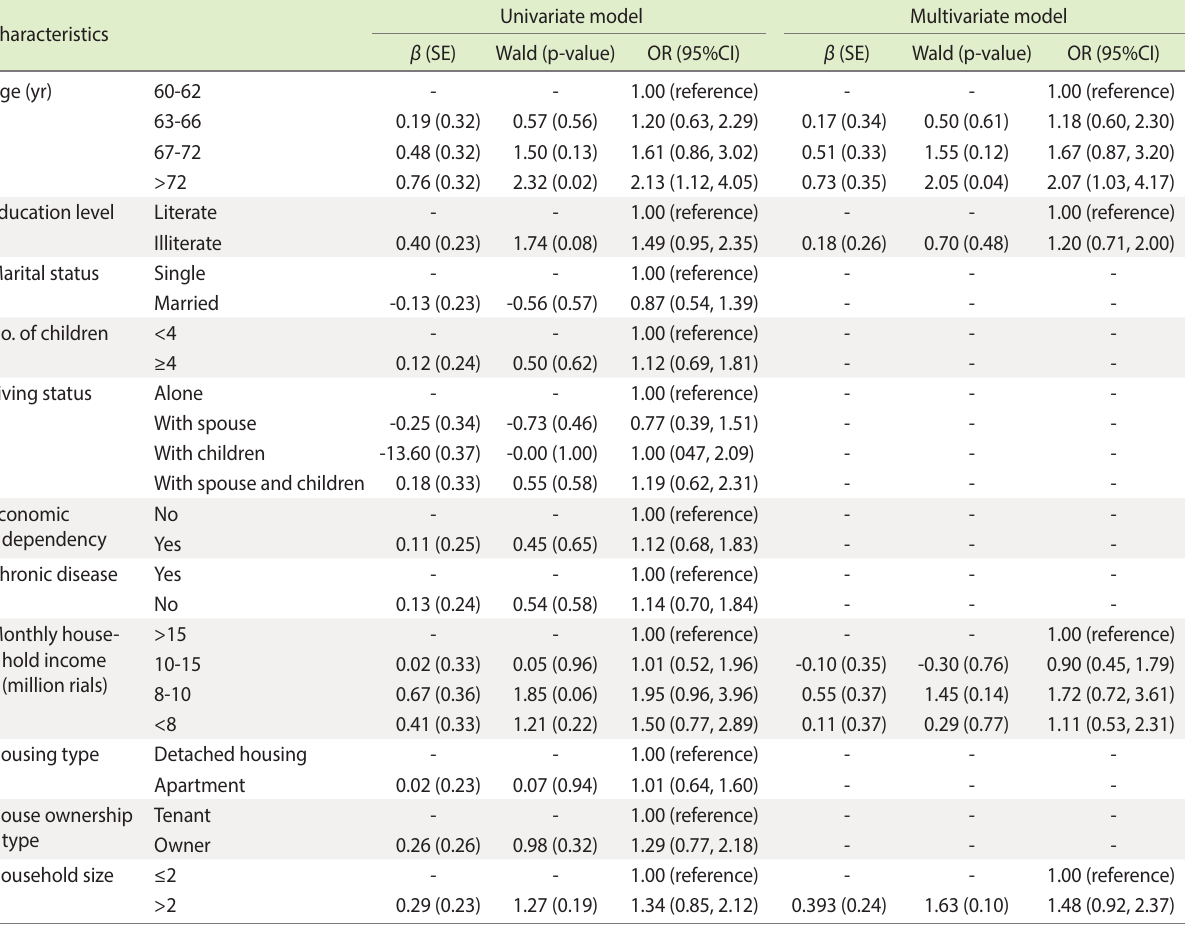
Table 3. The ordinal logistic regression analysis of factors related to elder abuse